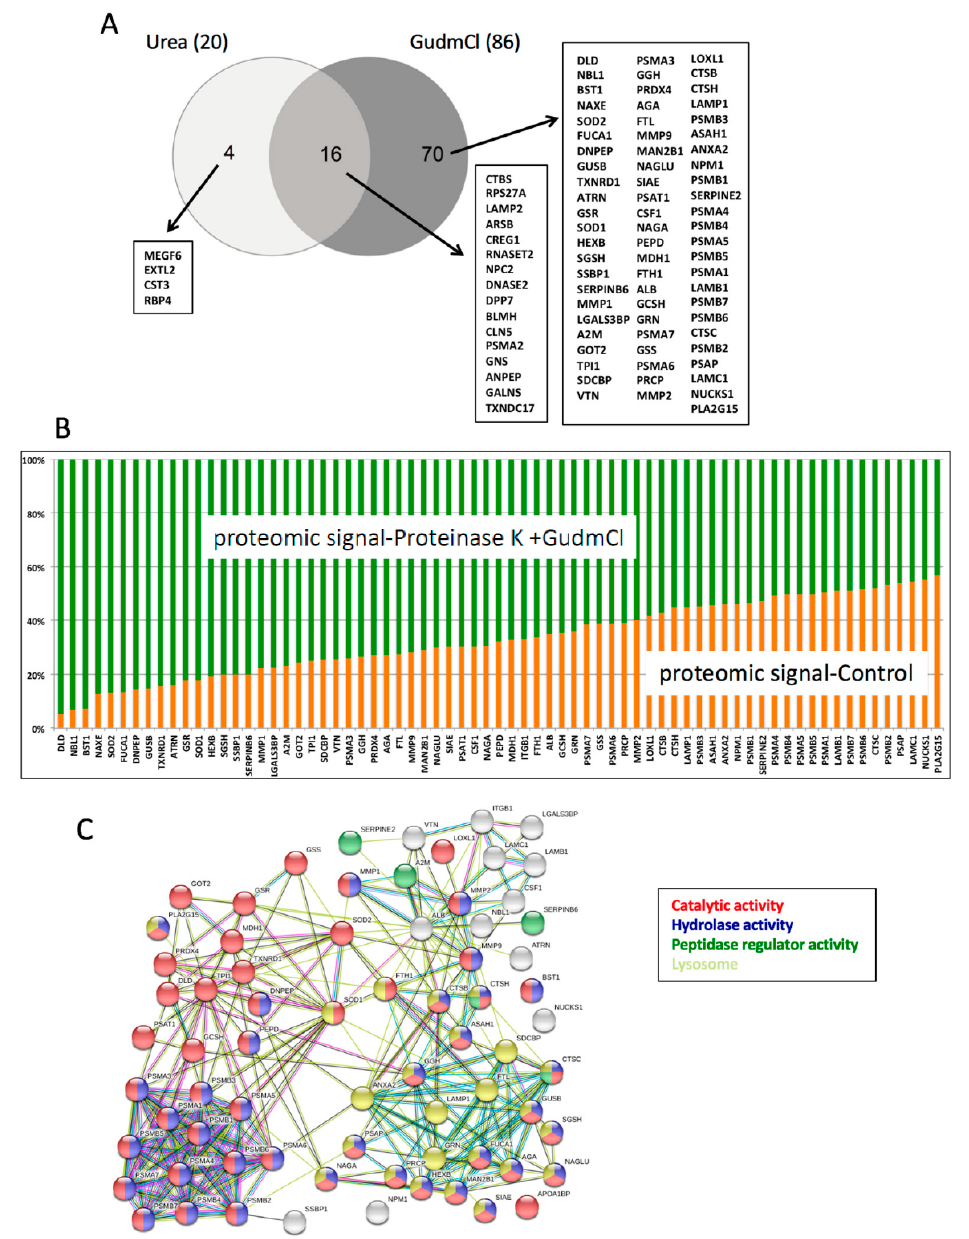
Figure 1. Proteolysis-resistant secretome screening as a tumor biomarker discovery approach. ( A ) Venn diagram showing an enrichment for a group of secretome proteins (labeled in the graph as GudmCl) that are not degraded by Prot K but need a harsh digestion protocol to be detected by LC-MS/MS. ( B ) Plot showing the different enrichment factors for the 70 proteins exclusively identified when using the Gu70-TrypLysC protocol. ( C ) STRING network analysis (https://string-db.org, accessed on 8 June 2020) of the 70 enriched proteins by Prot K digestion. The gene ontology analysis shows that most of these proteins are enzymes with hydrolase activity, or they reside in secretory granules and the lysosome.